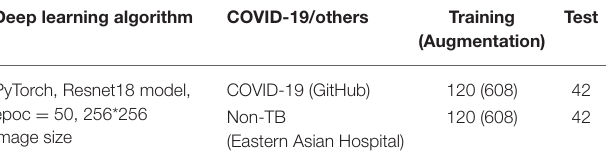
TABLE 4 | Data structure for AXIR4.